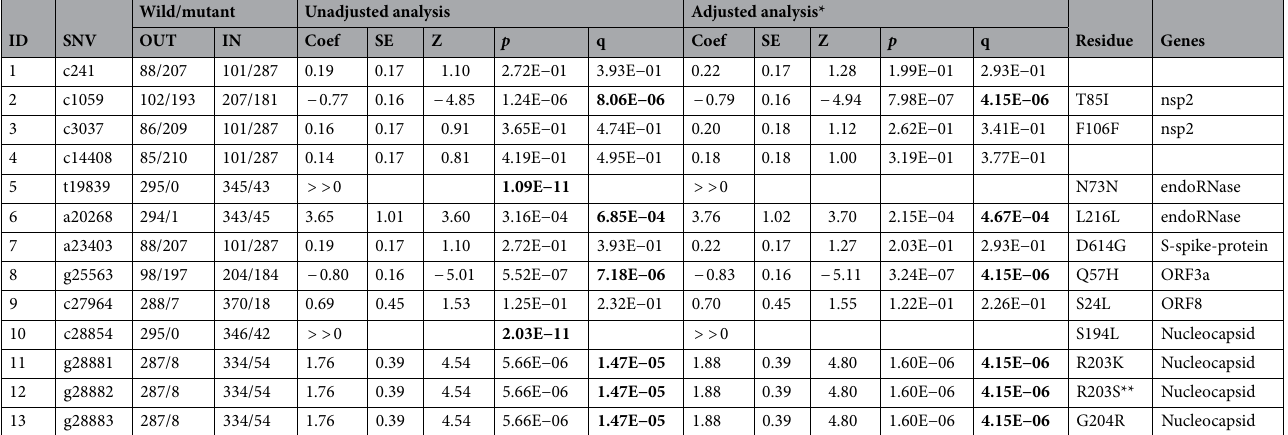
Table 2. Association results of selected SNVs (with at least 10 mutations) with hospitalization status (inpatient vs outpatient) in a case–control study of 683 Covid 19 cases: frequencies of wildtypes/mutations among outpatients and inaptients, estimated coefficients, standard errors, p -values, q-values, corresponding residue (if SNV is in the coding region), indicators for urgent SNVs, and corresponding genes. *The analysis adjusted age and sex. **R203S or